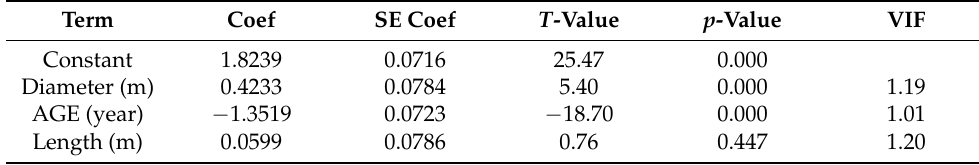
Table 3. Regression Analysis of Concrete sewer